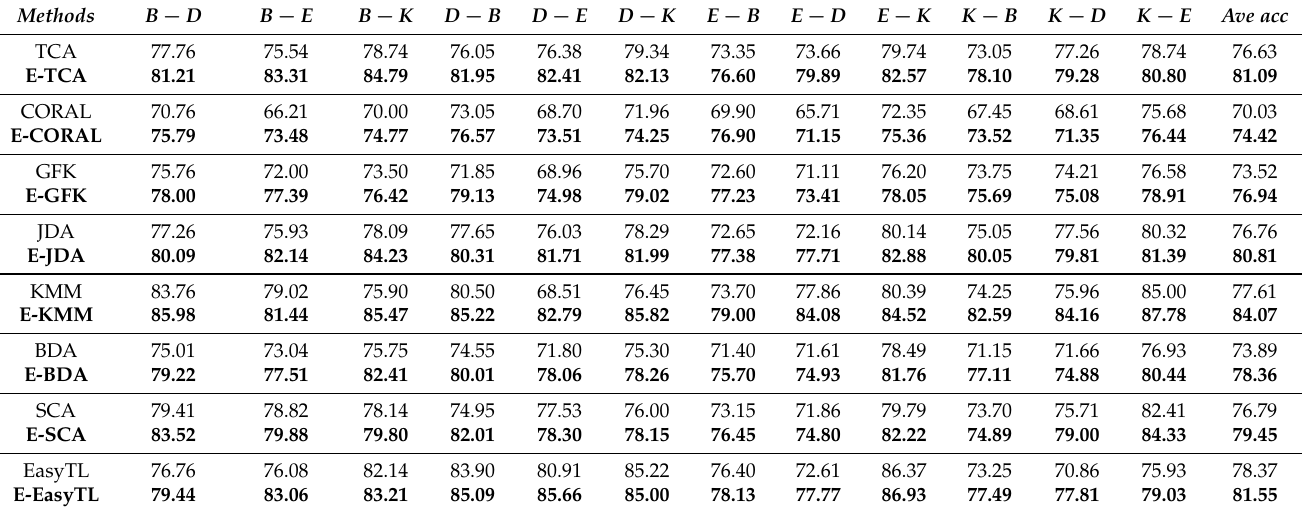
Table 3. Cross-domain sentiment classification accuracies of text dataset generated by the traditional TL methods with and without ensemble strategy.